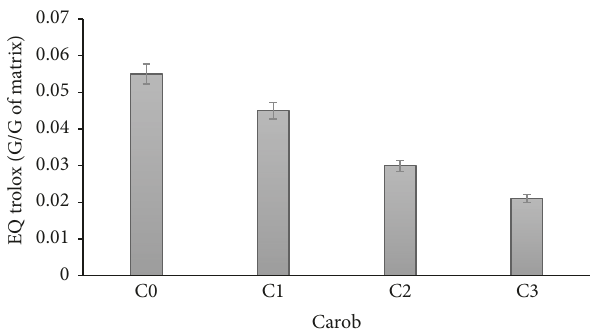
Figure 4: IC50 values determined by the DPPH assay for carob extracts obtained by